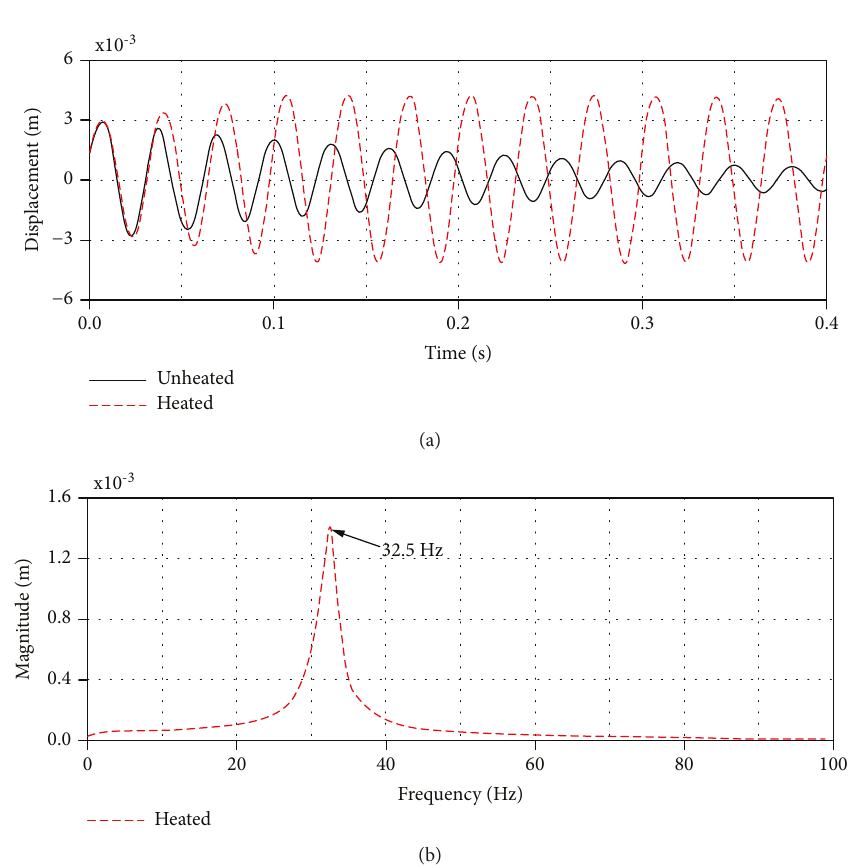
Figure 10: Time histories and FFT spectrum of wing tip displacement at M